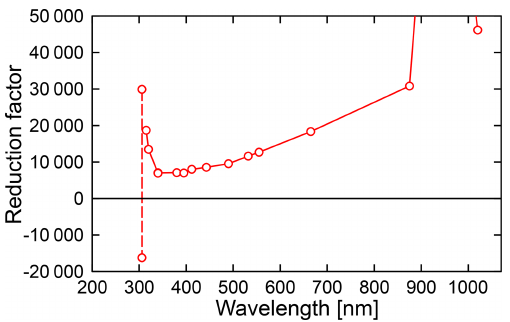
Figure 15. Factor to quantify the reduction of spectral irradiance during totality relative to spectral irradiance from the unoccluded Sun. Measurements of the two channels at 306nm are below the de- tection limit during totality, and the factors calculated for two chan- nels (connected by a dashed line) are therefore greatly different and meaningless. Factors for the other wavelengths with two channels (340 and 555nm) are virtually identical. The reduction factor for 940nm is